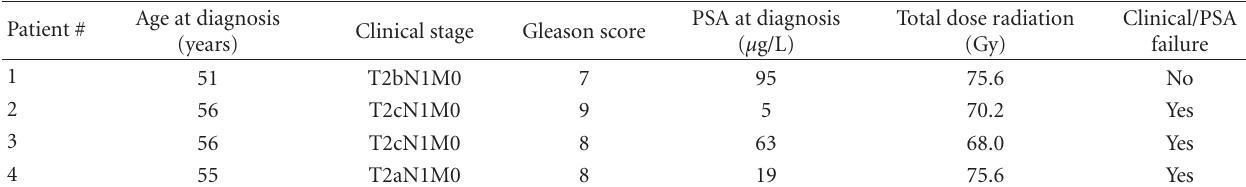
Table 2: Baseline patient characteristics and clinical/PSA failure status for patients with immunologic data and node positive disease. Patient